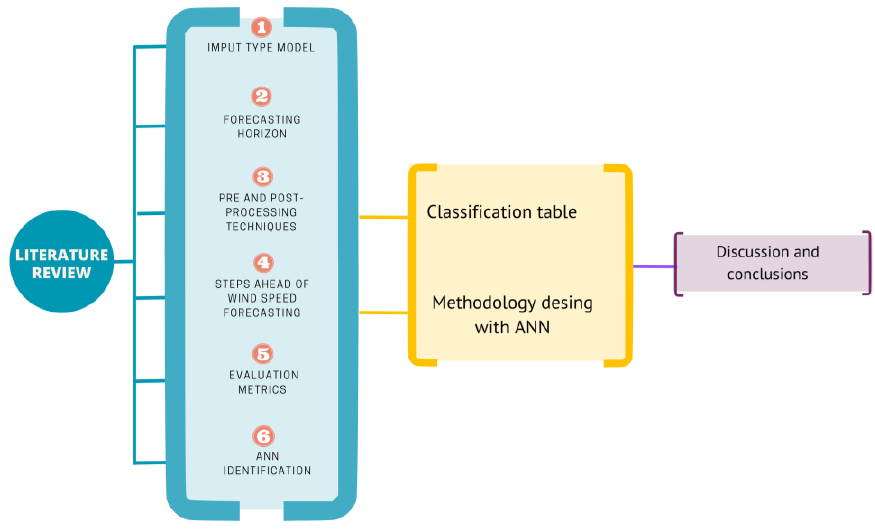
Figure 4. Methodology Flow Chart.